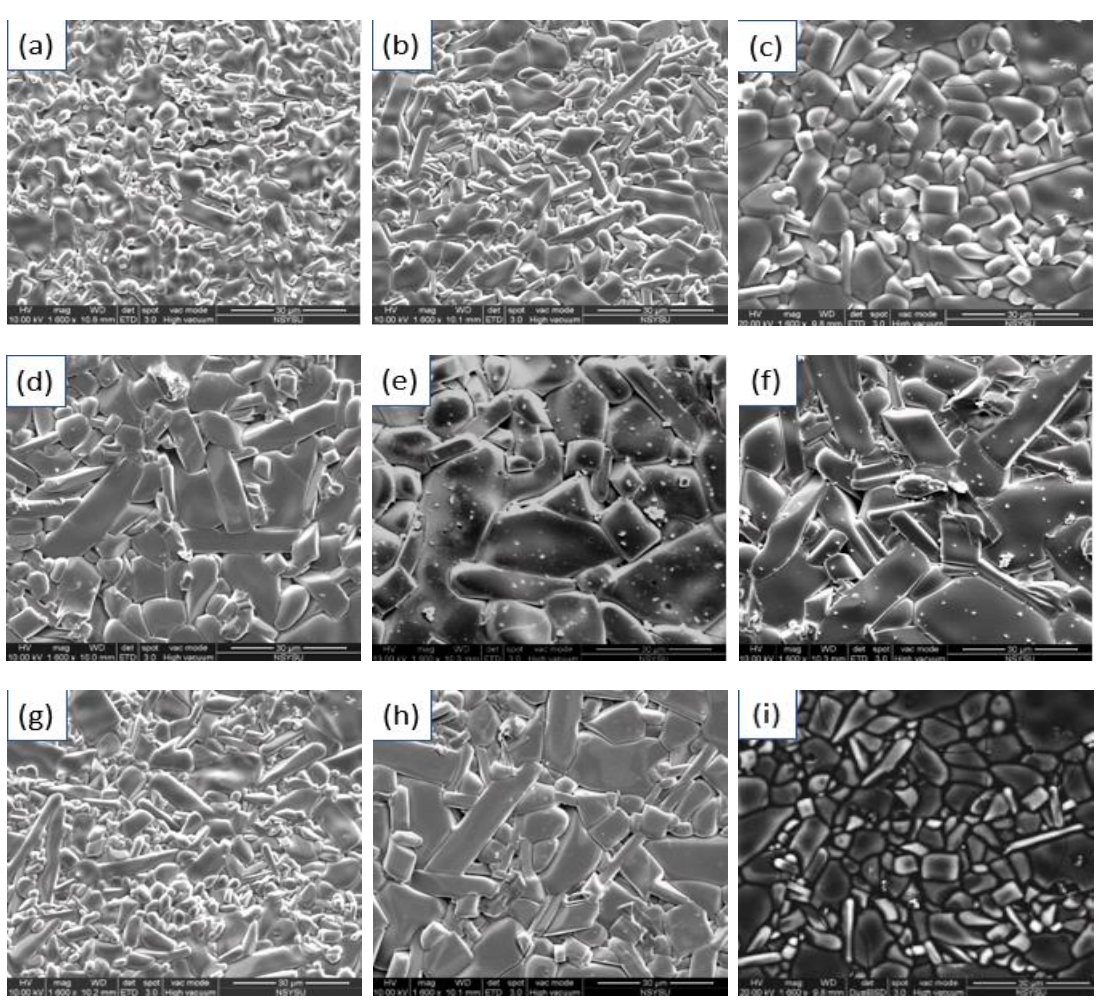
Figure 3. SEM photographs of MNT ceramics sintered at varied temperature holding times of 2–6 h and the BEI of MNT ceramics sintered at 1350 °C holding of 4 h: ( a )1300 °C; ( b )1325 °C; ( c )1350 °C; ( d )1375 °C; ( e )1400 °C; ( f )1425 °C; ( g ) 1350 °C/2 h; ( h )1300 °C/6 h ; ( i )BEI-1350 °C/4 h.